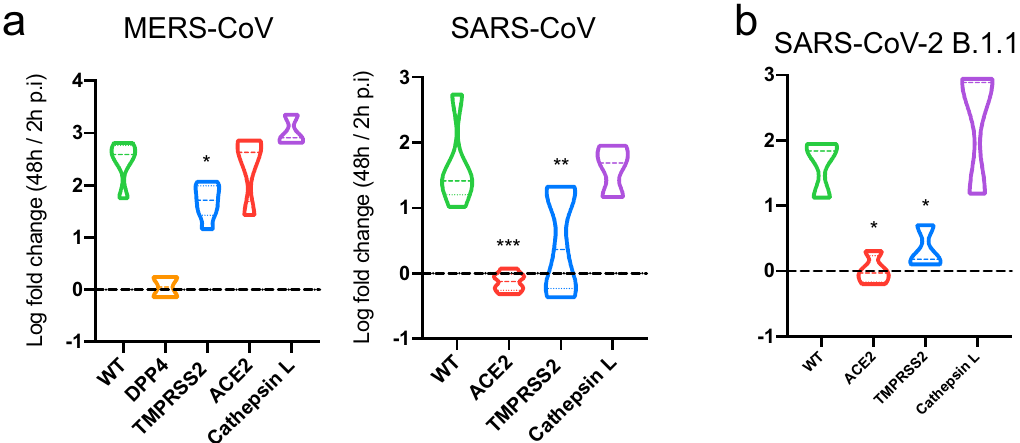
Fig. 6 Host protease dependency in the SARS-CoV-2 variant of concern B.1.1.7 and other coronaviruses. a Violin plot displaying the Log10 ratio between the viral titer at 48 h compared to 2 h post infection (p.i.) quanti fi ed by qPCR targeting the N gene (SARS-CoV) or upE region (MERS-CoV) to measure viral replication in WT and TMPRSS2 KO organoids. DPP4 and ACE2 data include replication curves in Fig. 3C and S4A. The dotted line indicates a fold change of 1. Dotted lines within the violins indicate the median and quartiles. For MERS-CoV: N = 5 for WT, N = 2 for DPP4, N = 7 for TMPRSS2, N = 4 for ACE2, N = 3 for CTSL. For SARS-CoV: N = 5 for WT, N = 6 for ACE2, N = 7 for TMPRSS2, N = 4 for ACE2, N = 3 for CTSL. Exact p values can be found in Supplementary dataset 5. b Violin plot displaying the Log10 ratio between the viral titer at 48 h compared to 2 h post infection (p.i.) quanti fi ed by qPCR targeting the E gene to measure viral replication of the SARS-CoV-2 B.1.1.7 virus in intestinal organoid cells harboring a loss-of-function mutation in the TMPRSS2 and CTSL proteases, or ACE2. The dotted line indicates a fold change of 1. Dotted lines within the violins indicate the median and quartiles. N = 4 for ACE2 and N = 3 for the remaining genes. Statistics were performed by one-way ANOVA followed by a multiple-comparison test (Original FDR method of Benjamini and Hochberg; Q = 0.05) on log10 transformed values in a and b if N was ≥ 3. * P < 0.05; ** P < 0.01; *** P < 0.001; **** P < 0.0001. Exact p values can be found in Supplementary dataset